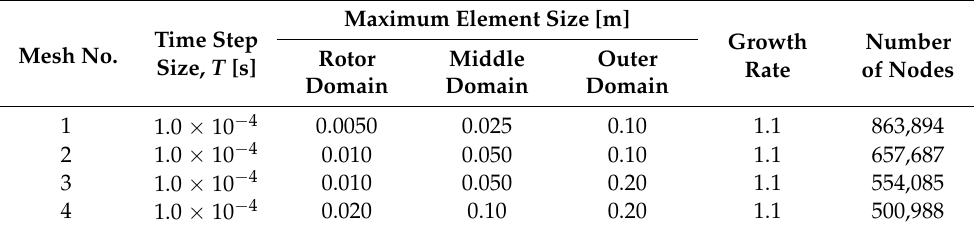
Table 1. Properties of the meshes evaluated in the grid independence study. Mesh